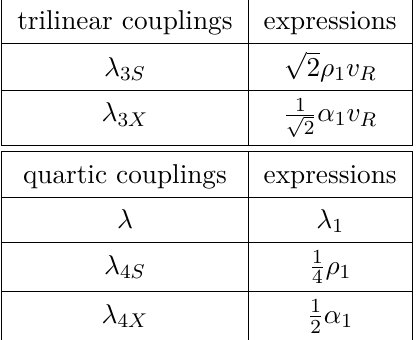
Table 4 . Trilinear and quartic couplings given in eq. (6.5) for a SM+singlet model derived from the